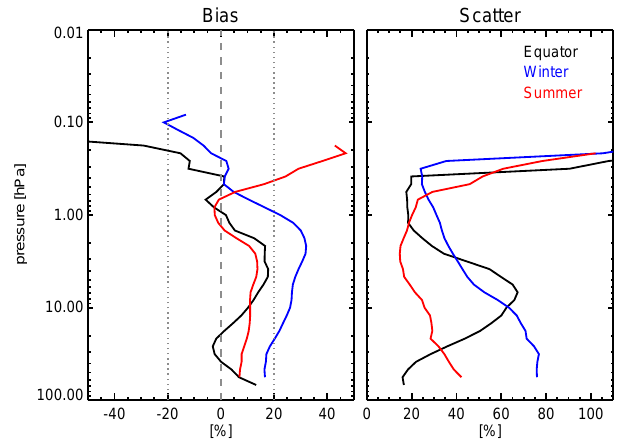
Fig. 20. Mean CH 4 bias (left) and scatter (right) between the MIPAS linear retrieval and MORSE. The grey dotted line shows the expected equatorial CH 4 variability. The grey dashed line shows a 3 K difference.